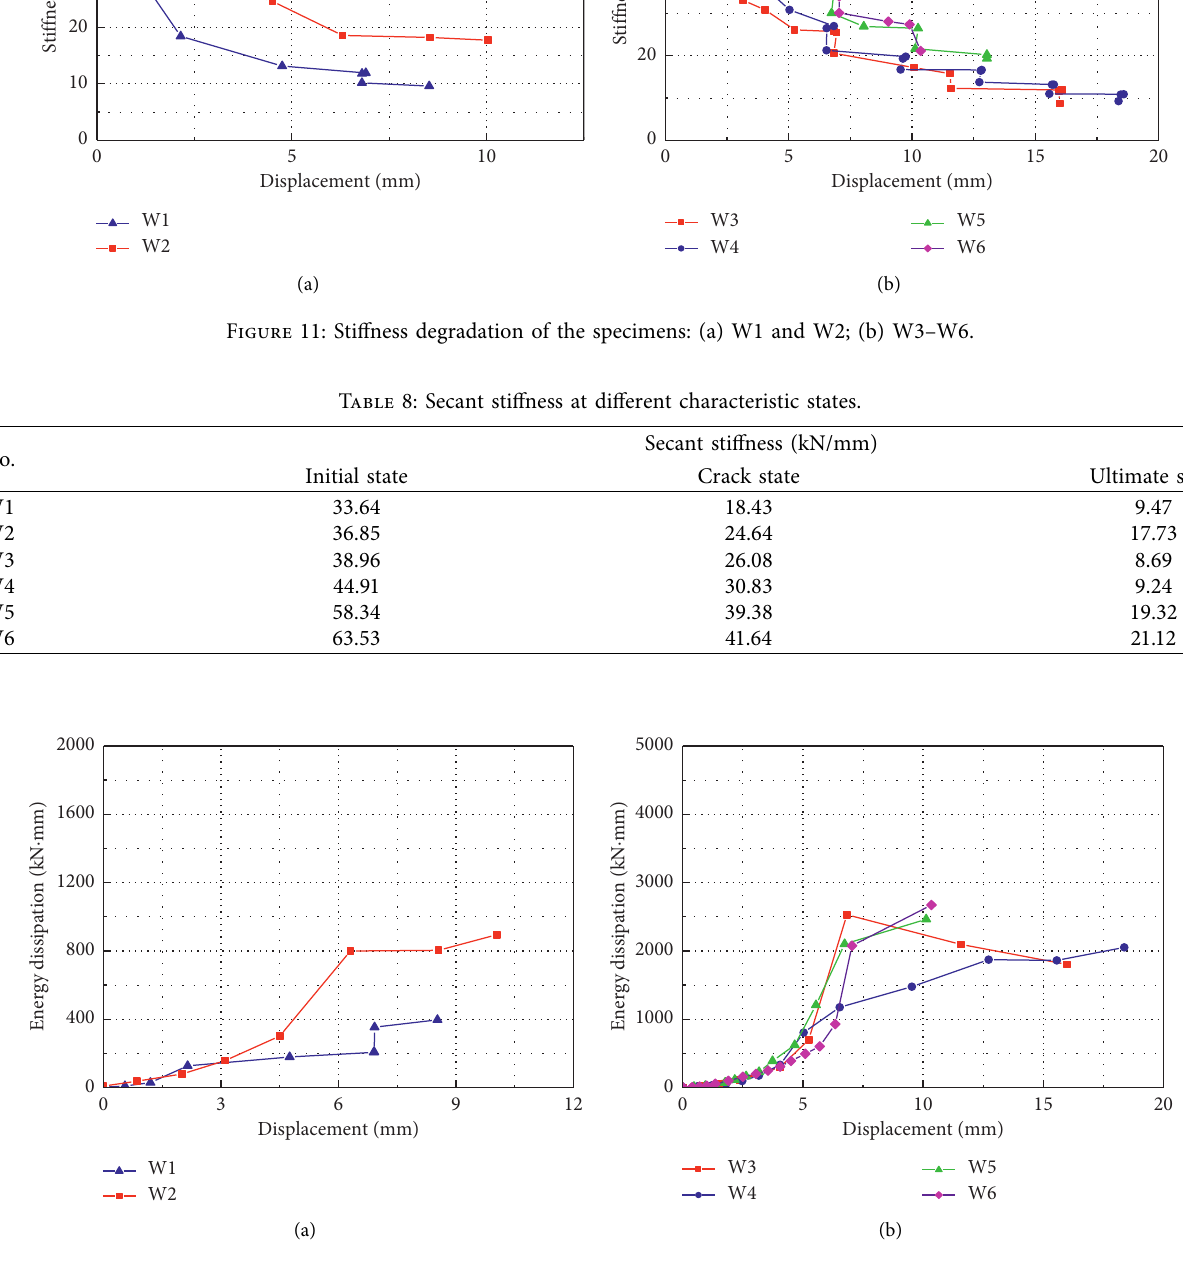
Figure 12: Energy dissipation of the specimens: (a) W1 and W2; (b)